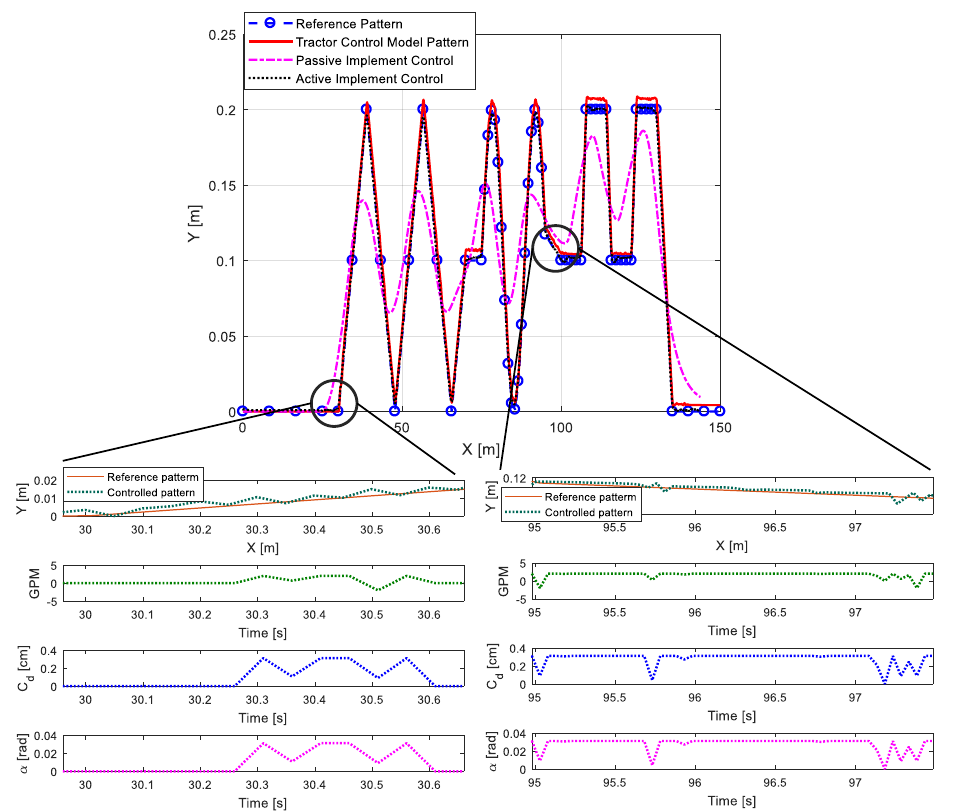
Figure 10 . Time delay between sending correcting signals to pump and taking action by cylinder . Figure 10. Time delay between sending correcting signals to pump and taking action by